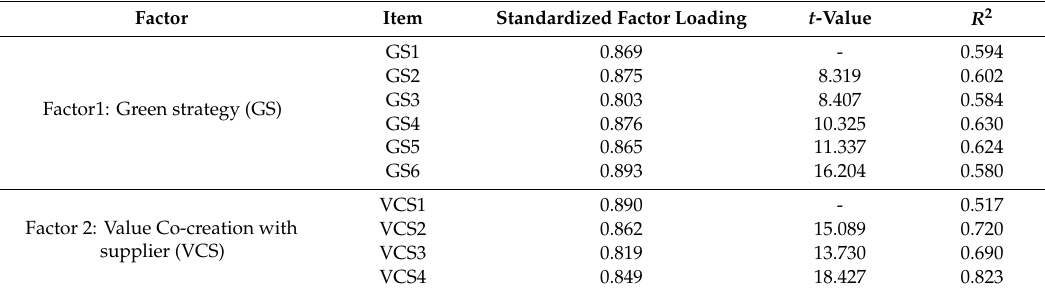
Table 3. Parameter estimates of the confirmatory factor